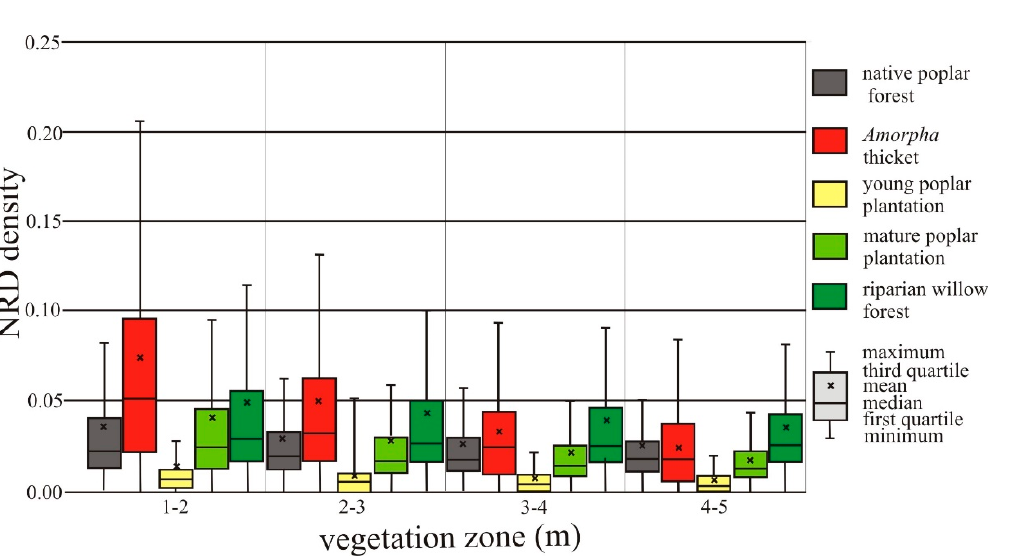
Figure 11. The NRD density in vegetation categories at different zones of the vegetation. Table 5. Frequency (%) of vegetation density categories in the different flooded height zones. Vegetation Density